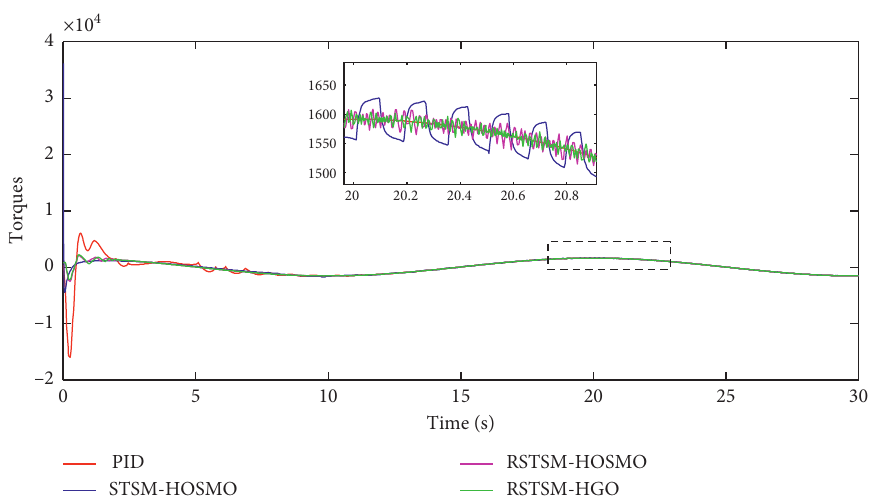
Figure 10: Temporal evolution of the control